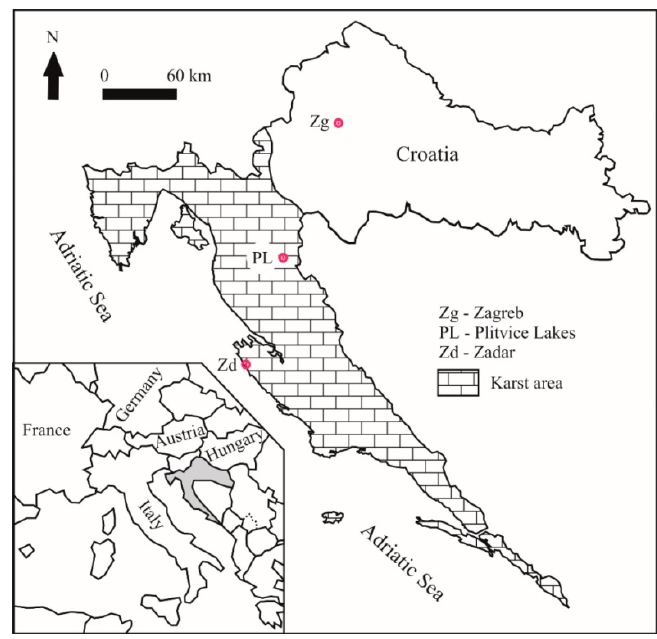
Figure 1. Map of Croatia and the position of the study area: Zagreb (Zg), Plitvice Lakes (PL), and Zadar (Zd).